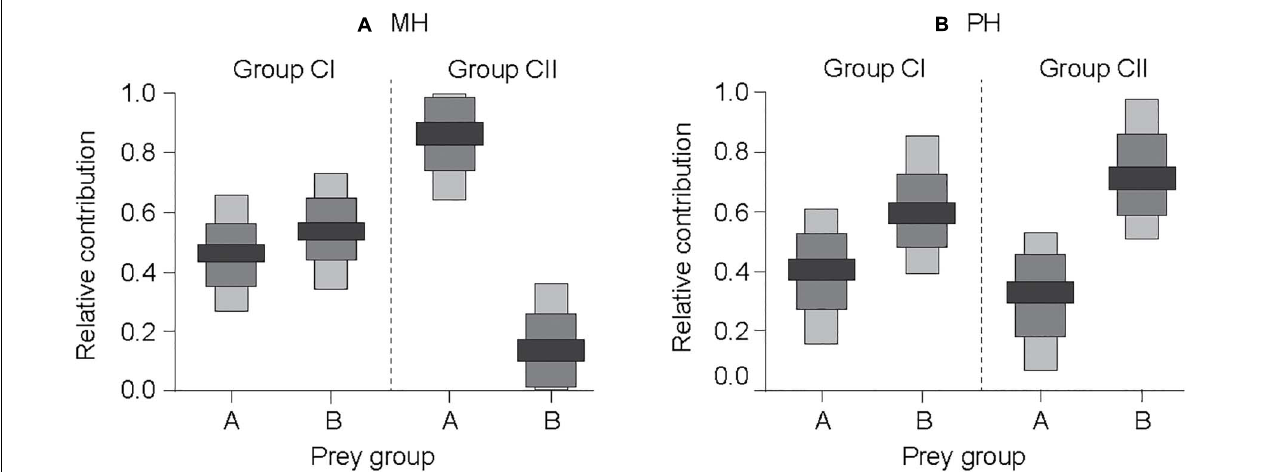
FIGURE 6 | Relative contributions (50, 75, and 95% confidence intervals as indicated by black, dark gray, and light gray colors, respectively) of benthic- vs. pelagic-affinity primary consumer groups to the nutrition of higher-level consumers at the MH (A) and PH (B) sites, which were estimated using the Bayesian isotopic mixing model. Prey groups A and B represent suspension feeder and herbivore-deposit feeder groups, respectively, as identified by the hierarchical cluster analysis. Groups CI and CII indicate the subgroups clustered for predatory taxa.